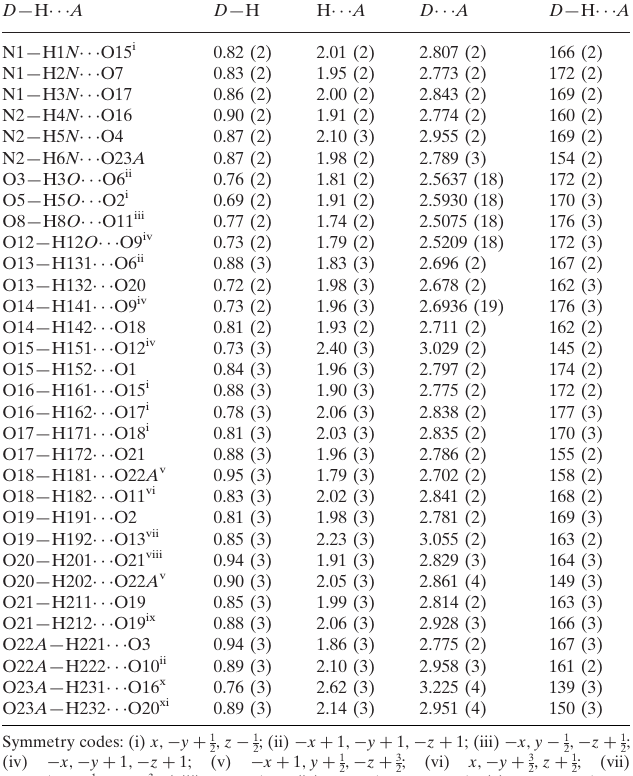
Hydrogen-bond geometry (A˚ , (cid:3)